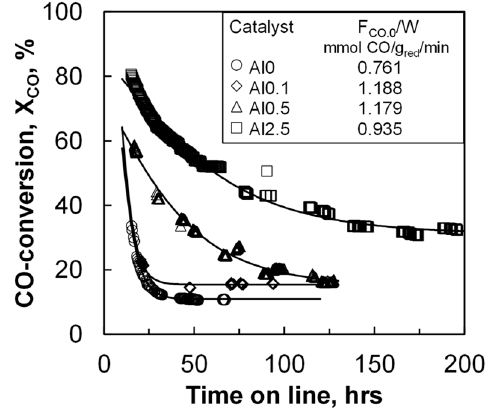
Figure 1. Initial CO conversion in the Fischer–Tropsch synthesis in a slurry reactor at 220 °C, 20 bar and a feed containing H 2 :CO:Ar = 2:1:1 as a function of time on line (solid lines represent fit to the model – see text).